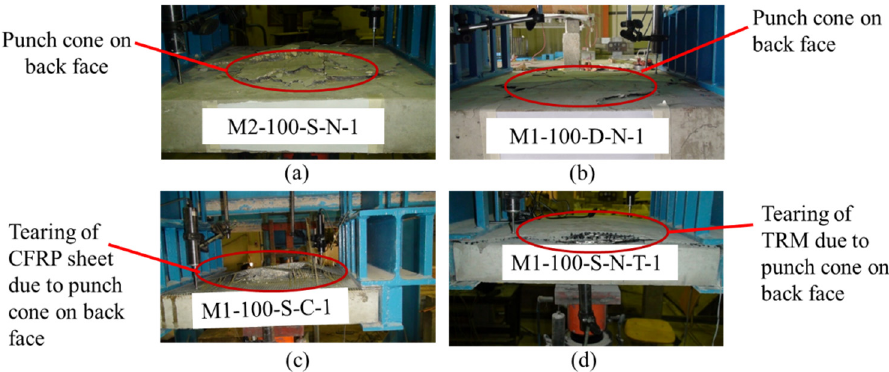
Figure 4. Quasi-static punching failure of: ( a ) M2-100-S-N-1; ( b ) M1-100-D-N-1; ( c ) M1-100-S-C-1; and ( d ) M1-100-S-N-T-1.